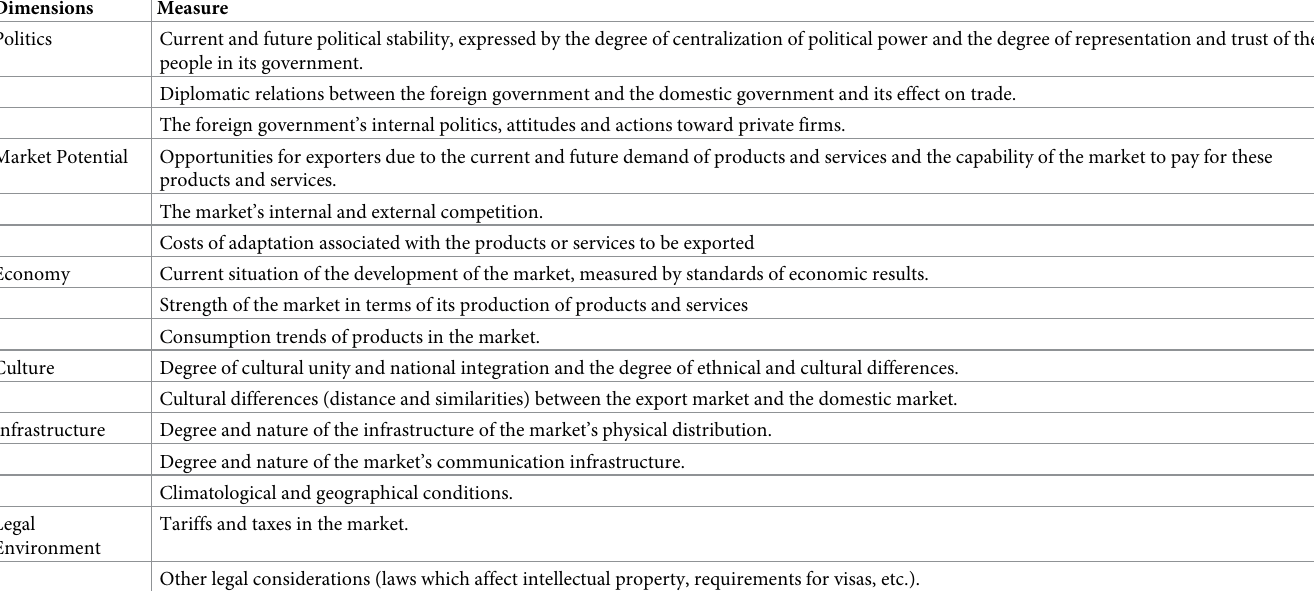
Table from Wood VR, Robertson KR. (2000) Evaluating International Markets: The Importance of Information by Industry, by Country of Destination and by Type of Export Transaction. International Marketing Review. 17 (1):